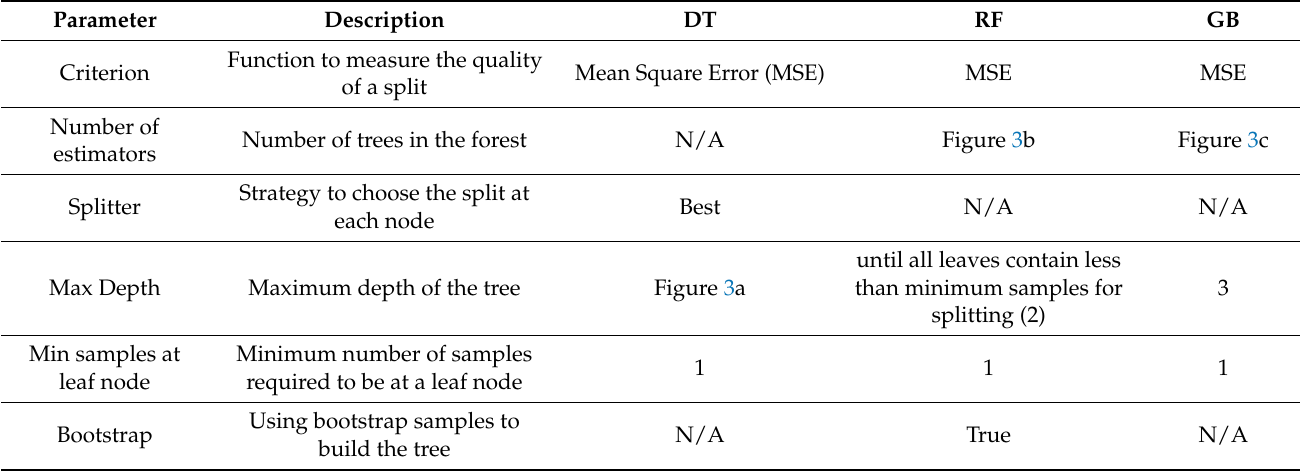
Table 3. Additional parameters for the decision tree, random forest, and gradient boosting regressors used in this